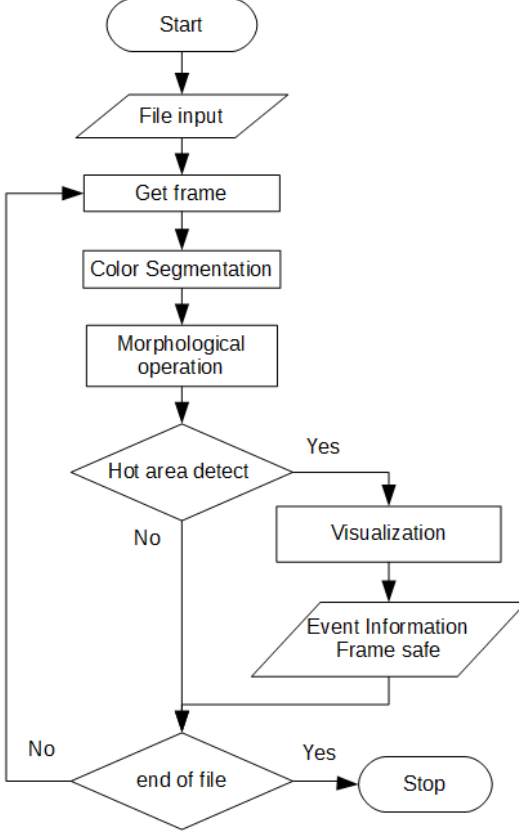
Figure 16. An algorithm of hot area